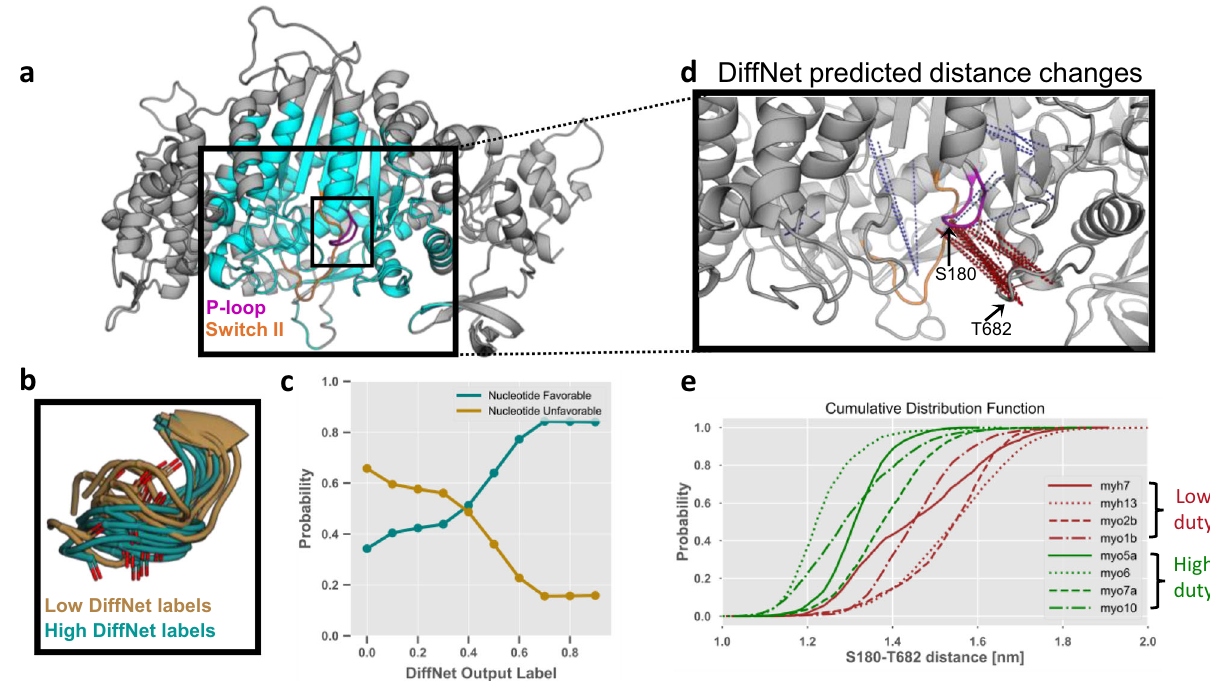
Fig. 7 DiffNets capture the importance of P-loop motions in distinguishing high and low duty myosin motor proteins. a Structure of a myosin motor protein (PDB ID: 4PA0) showing the DiffNet classi fi cation region (cyan), the P-loop (magenta), and Switch-II (Orange). b Twenty states predicted by the DiffNet as high duty (teal) and low duty (dark gold). Predicted high duty states are mostly in a nucleotide compatible, P-loop “ down ” conformation and vice-versa for predicted low duty states. c Percentage of nucleotide favorable (teal) and unfavorable (dark gold) states as a function of the DiffNet output label, measured with 10 equally spaced bins with labels spanning 0-1. Most structures with low Diffnets labels are nucleotide unfavorable, and vice-versa. d Inset of the myosin active site. Dotted lines indicate distances between two atoms that change in a way that is strongly correlated with an increased DiffNet output label. Red indicates the atoms move closer together as the output label increases, blue indicates atoms moving away from each other. e Cumulative distribution function showing the distance between S180 (P-loop) and T682 ( β 3-SH2 loop). Probabilities come from a previously published MSM 47 . This distance clearly separates high and low duty motors (green and light brown, respectively) as predicted by the DiffNet in d